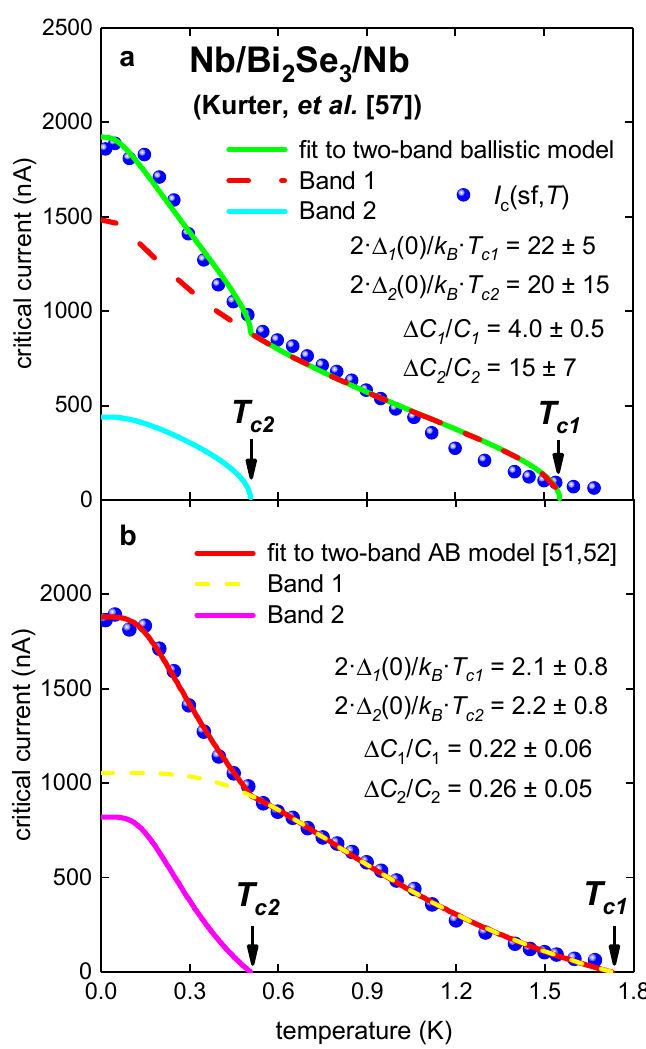
Figure 6. Experimental I c ( sf, T ) for Nb/Bi 2 Se 3 /Nb junction [57]. ( a ) Ballistic model, fit quality is R = 0.994; ( b ) modified AB model [51,52]. Derived parameters: R n1 = 240 ± 100 Ω , R n2 = 92 ± 33 Ω . Fit quality is R = 0.9991. Table 6. Deduced parameters for for Nb/Bi 2 Se 3 /Nb junction [57] from fit to two-band Titov and